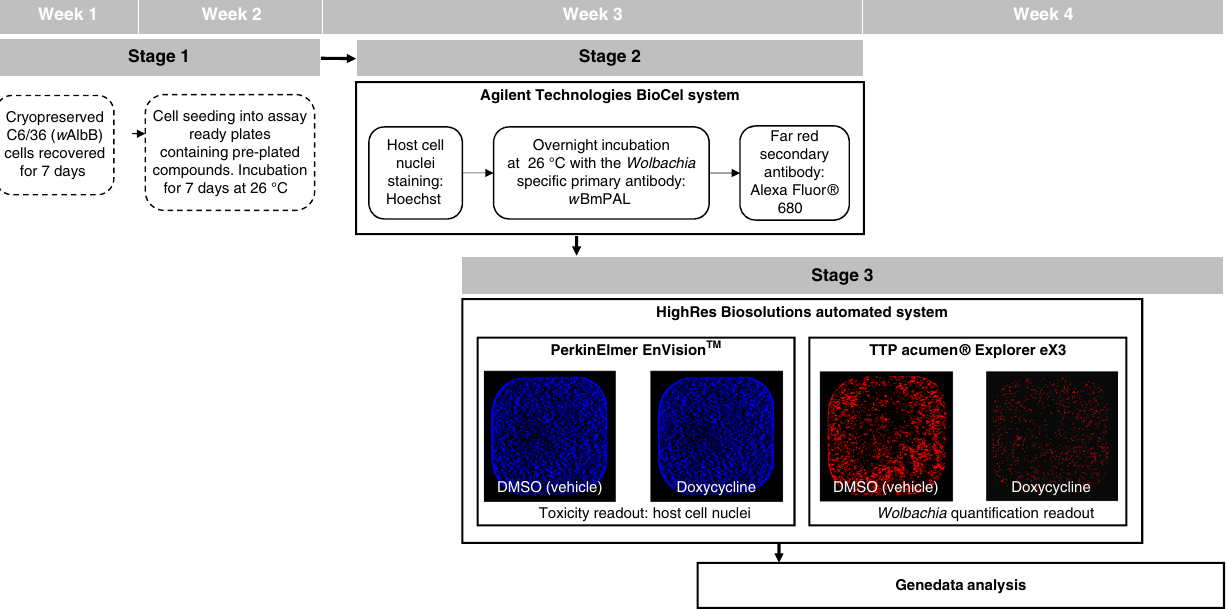
Fig. 1 The high-throughput anti- Wolbachia screening fl ow. This extensive 16-step screen per batch across all three stages was completed over 3 weeks followed by over fl ow plate reading and data analysis in the 4th week when at full capacity of four daily batches of 150 plates per week. Manual processes are indicated by dashed boxes and fully automated steps in solid boxes. Bold rectangular boxes indicate the use of the fully automated systems: Agilent technologies BioCel system and HighRes Biosolutions automated system. The fl uorescent images are representatives of the host nuclei (Hoechst) and Wolbachia ( w BmPAL) staining taken from a whole well image (growth area of 10 mm 2 ) on the acumen ® to demonstrate cells incubated with the vehicle/ DMSO and doxycycline